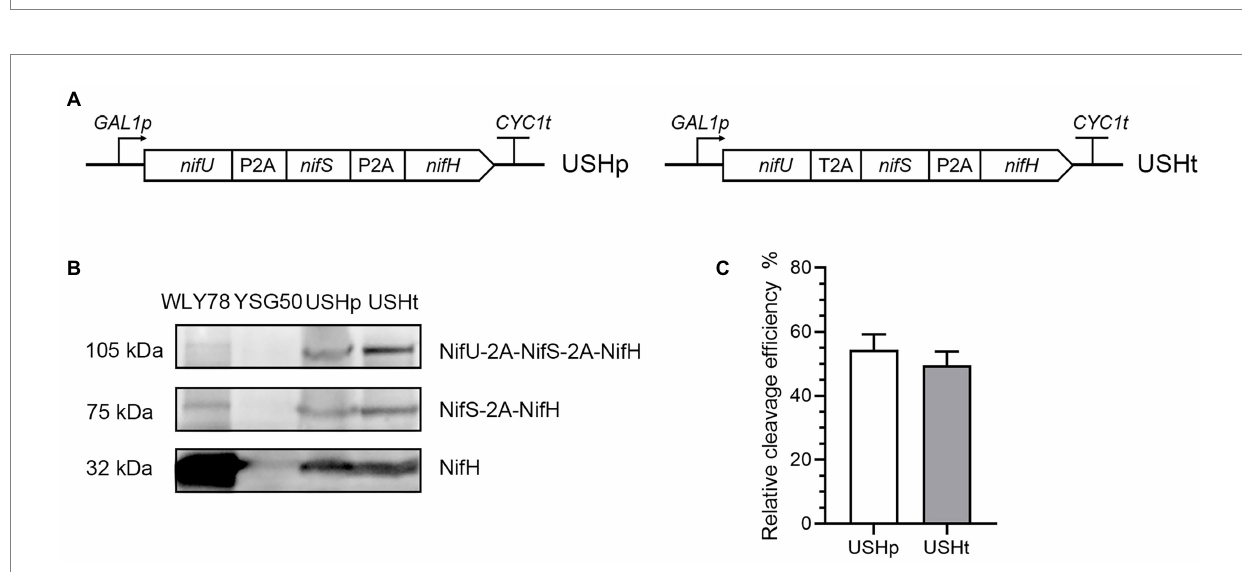
FIGURE 3 Co-expression of P . polymyxa NifH and K . oxytoca NifU and NifS linked via 2A peptides in yeast. (A) Scheme of nifU -2A- nifS -2A- nifH fusion under control of GAL1 promoter in the constructed recombinant vectors. (B) Western blotting analysis of NifH and its fusions in the recombinant strains S . cerevisiae USHp and USHtm. S . cerevisiae YSG50 was used as negative control and P . polymyxa WLY78 was used as positive control. (C) Quantitation of cleavage efficiency of the second 2A sequence. Cleavage efficiency = NifH/(NifH+NifS-2A-NifH+NifU-2A-NifS-2A-NifH) *100%. The band intensity on the Western blotting measured by ImageJ software. Error bars indicated SEM, n = 3. USHp: S . cerevisiae USHp, USHt: S . cerevisiae